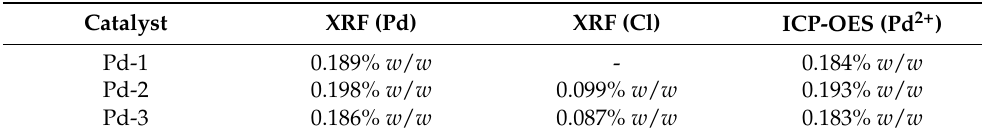
Table 1. XRF and ICP-OES results of catalysts Pd-1, Pd-2 and Pd-3.